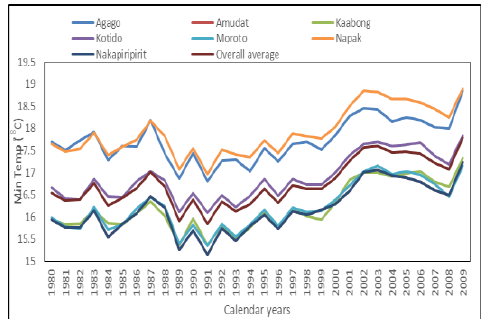
Figure 2. Historical rainfall trend for Karamoja sub-region.